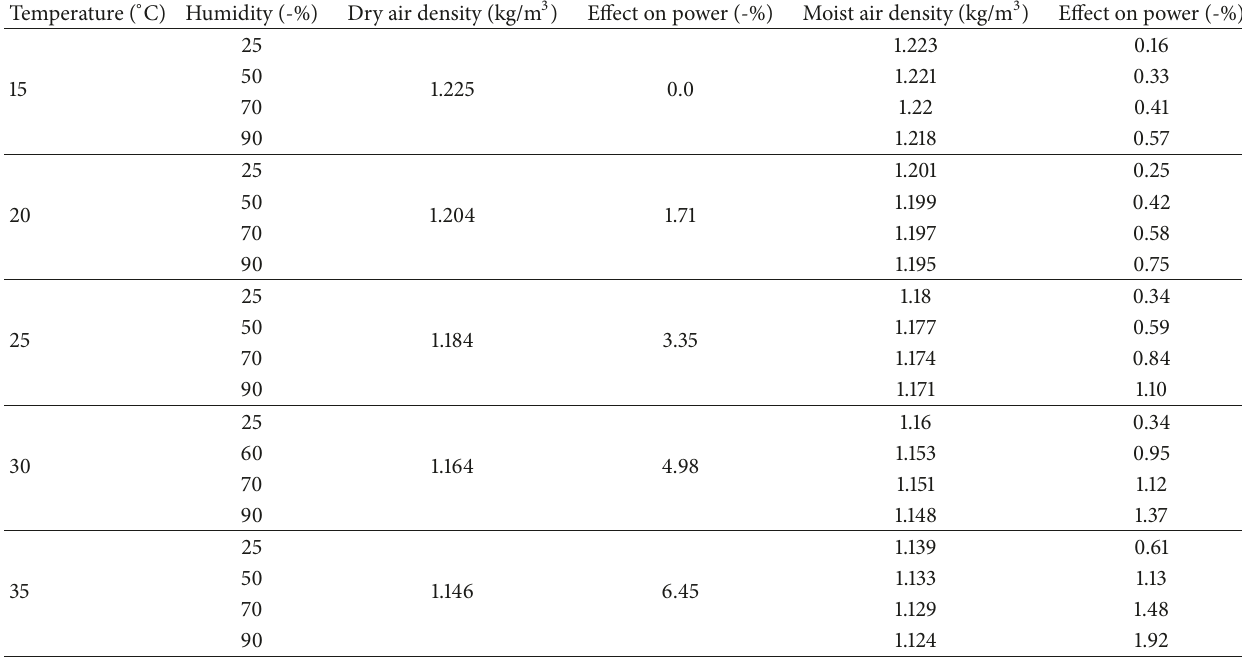
Table 1: Air density versus air relative humidity and its effect on power.